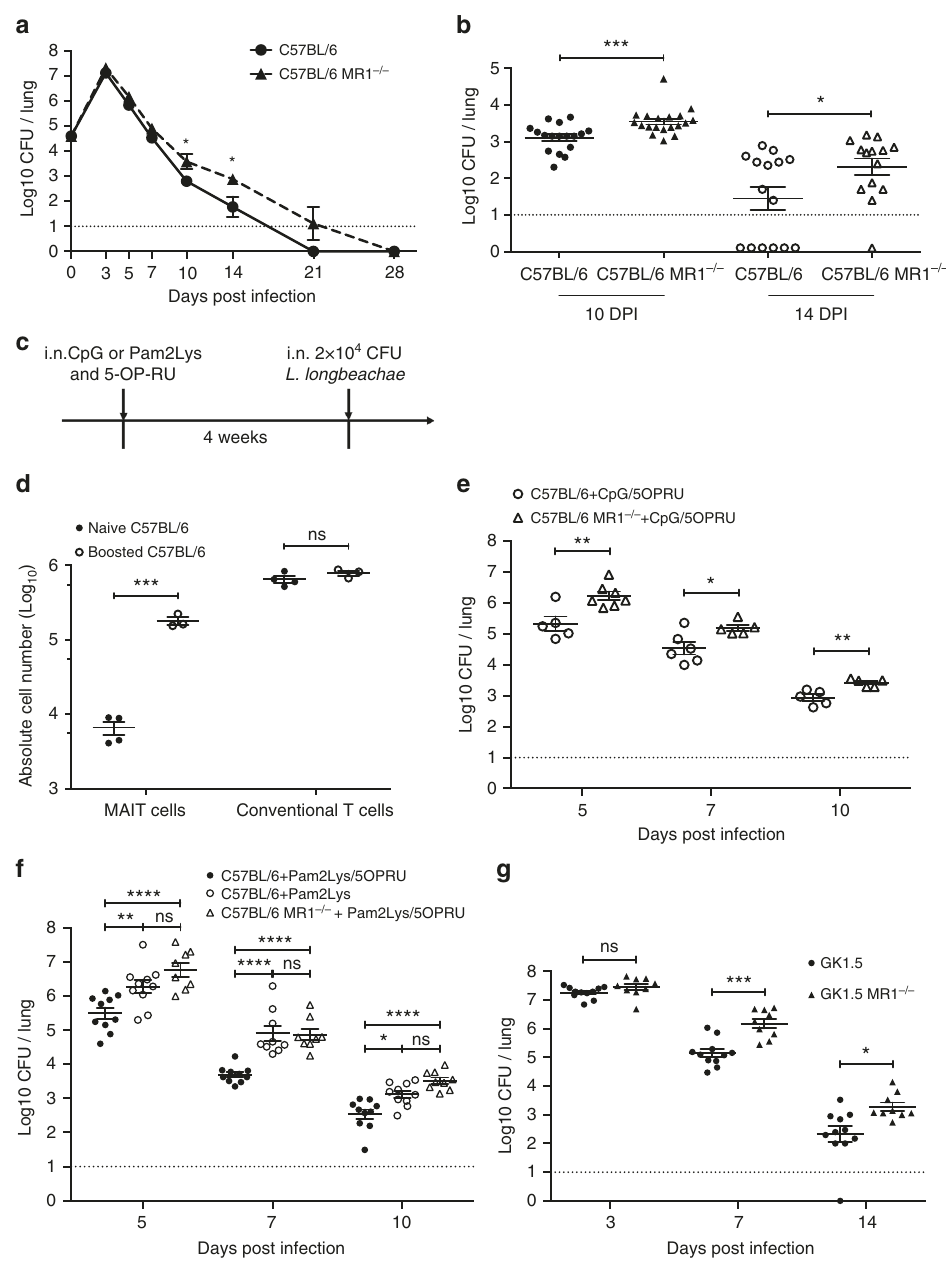
Fig. 5 MAIT cell protection in Legionella infection accelerated by MAIT cell expansion. a , b Bacterial load (CFU) in lungs of C57BL/6 or MR1 − / − mice following intranasal infection with 2 × 10 4 CFU L. longbeachae . Dashed line represents limit of detection. a Bacterial load over the time-course of infection. b Bacterial load at days 10 and 14 post-infection, from three independent experiments. Pooled data were compared using a Mann-Whitney test. c Schematic for d , e : C57BL/6 or MR1 − / − mice were treated with 20 μ g CpG ( d , e ) or 20 nmol Pam2Lys ( f ) in combination with 76 pmol 5-OP-RU (in 50